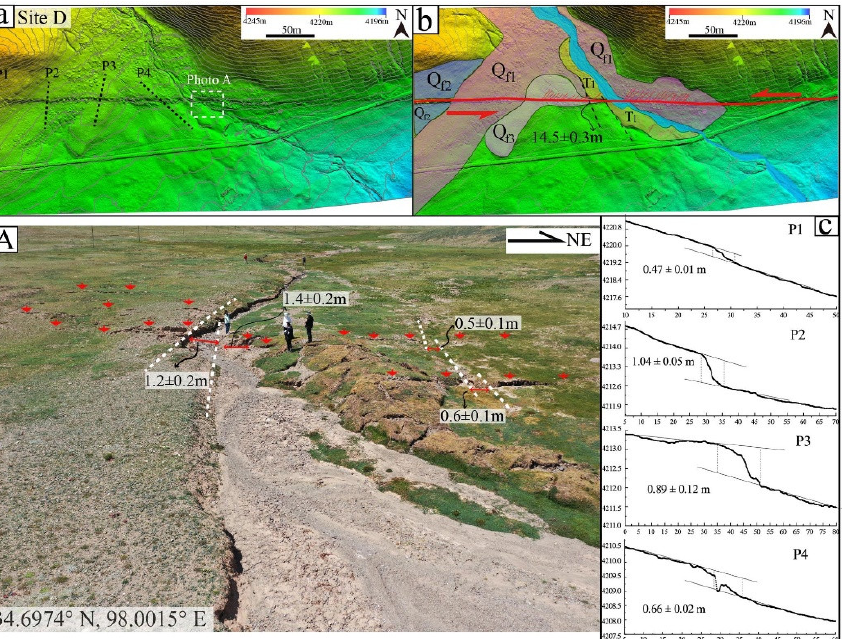
Figure 14. Co-seismic surface rupture along the preexisting fault where both co-seismic displacements and cumulative displacements were observed. ( a ) High-resolution DSM image of displacements at the observed site. ( b ) The geomorphic explanation of ( a ). ( c ) The profiles (p1–p4) show different levels of co-seismic fault scarp heights on alluvial fans (Qf1–Qf3) and on terrace T1. ( A ) Field photo of left-lateral displacements of the stream banks (location index in ( a )) by 1.2 ± 0.2 m (southwest bank) and 1.4 ± 0.2 m (northeast bank), and small gullies nearby were dislocated by 0.6 ± 0.1 m and 0.5 ± 0.1 m.